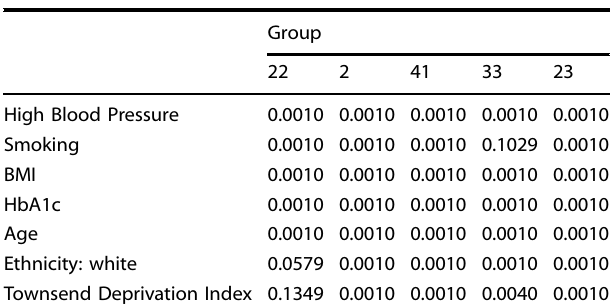
Table 2. Permutation test